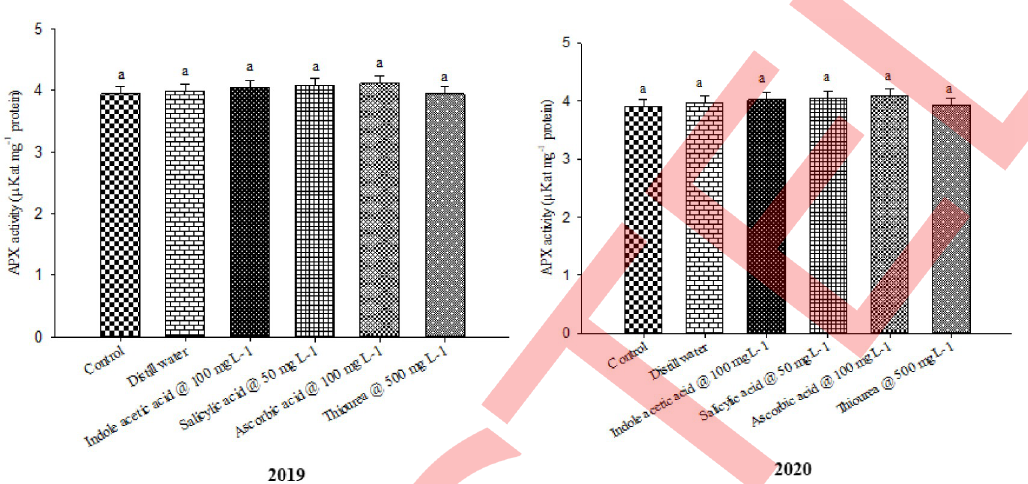
Fig 5. The influence of seed priming with different growth regulators on APX contents of Indian squash. The error bars represent ± standard error of the means. Alphabets on bar showed a significant difference ( P � 0.05) among seed priming techniques.